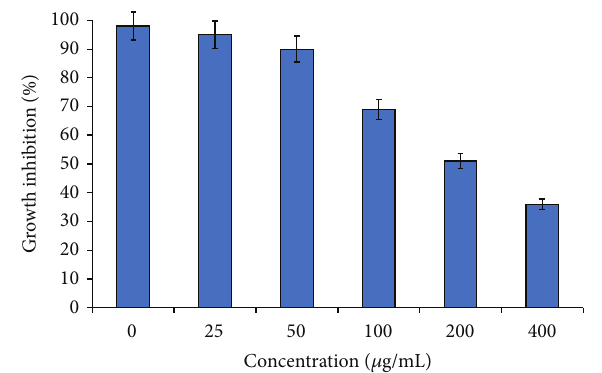
Figure 4: Effect of 𝛼 -Fe 2 O 3 on the growth of breast cancer cell lines MCF-7. Cells are seeded in 96-well plates and incubated with dif- ferent concentrations of 𝛼 -Fe 2 O 3 and noted after 24 h maintaining at 37 ∘ C. Cell viabilities are determined by 3-(4,5-dimethylthiazol-2- yl)-2,5-diphenyltetrazolium bromide (MTT) assay. Data points are presented as means ± SD of triplicate experiments.